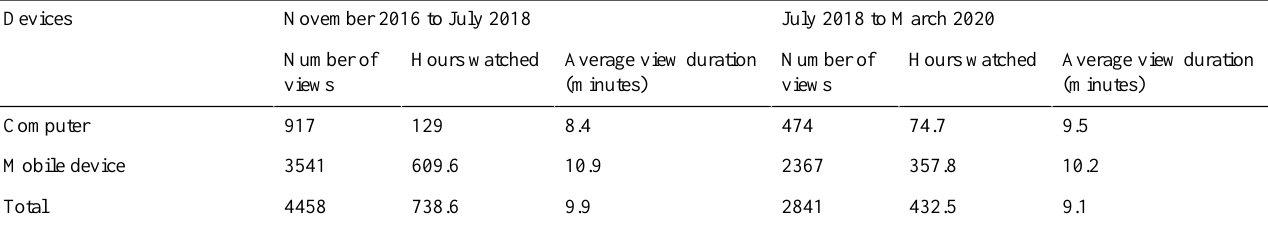
Table 2. Devices used for viewing videos.